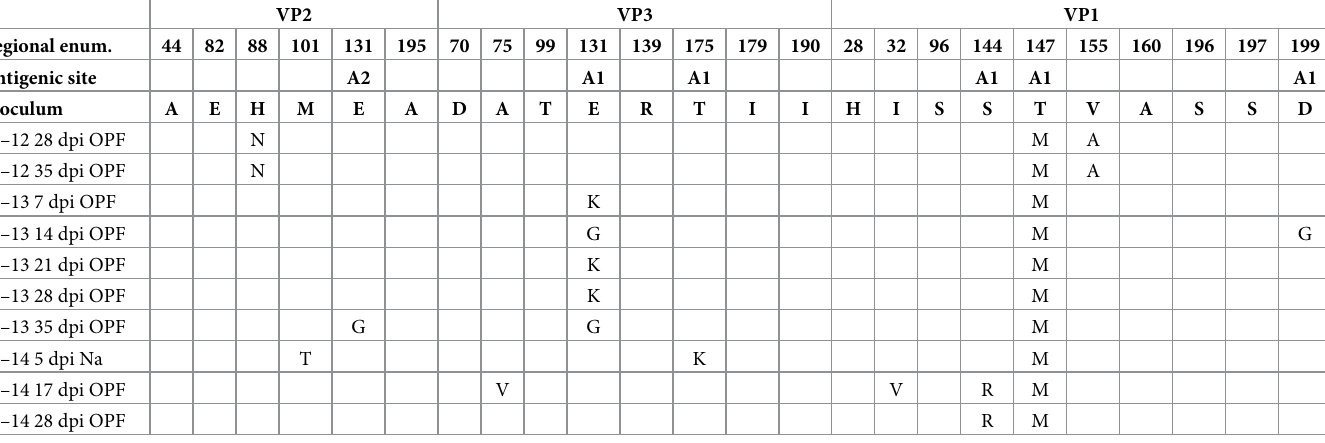
dpi: days post infection. Np: nasopharyngeal tissue. Ves: vesicular epithelium. Sa: saliva, Se: serum, Na: nasal fluid, OPF: oropharyngeal fluid. Antigenic sites A1 and A2 are as annotated in Fig